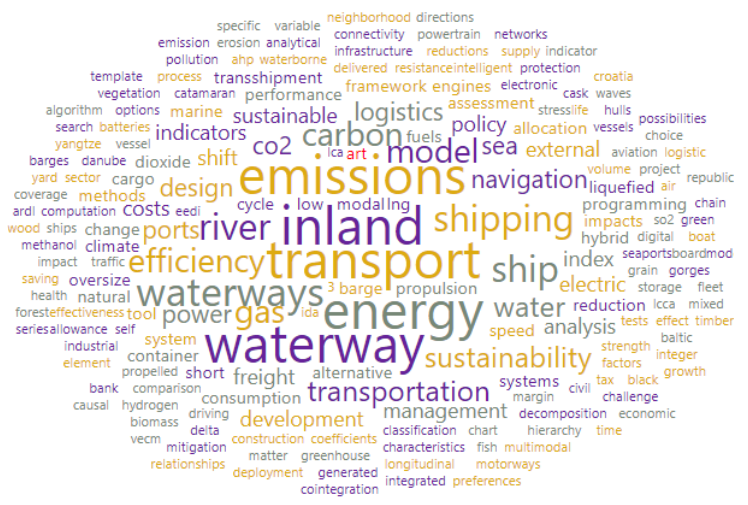
Figure 1. Word cloud from papers on the energy consumption of inland waterway transport. Source: Table 1. Topic modeling using the Latent Dirichlet Allocation technique and